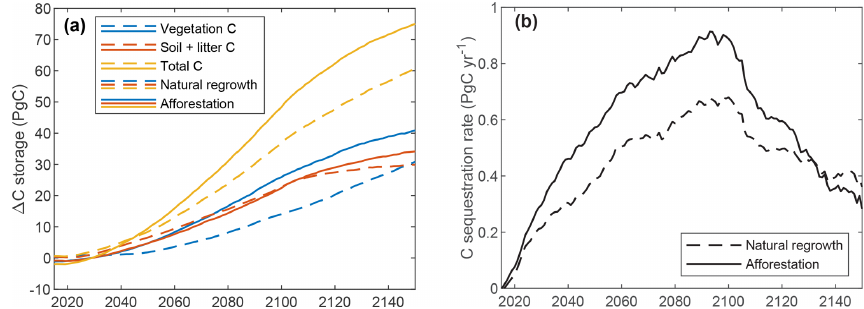
Figure 9. Results of the simulations for gradual afforestation and natural regrowth. Both graphs show differences relative to the baseline simulation with constant land use. (a) Global C storage; (b) global C sequestration rate, smoothed using a 10-year moving average